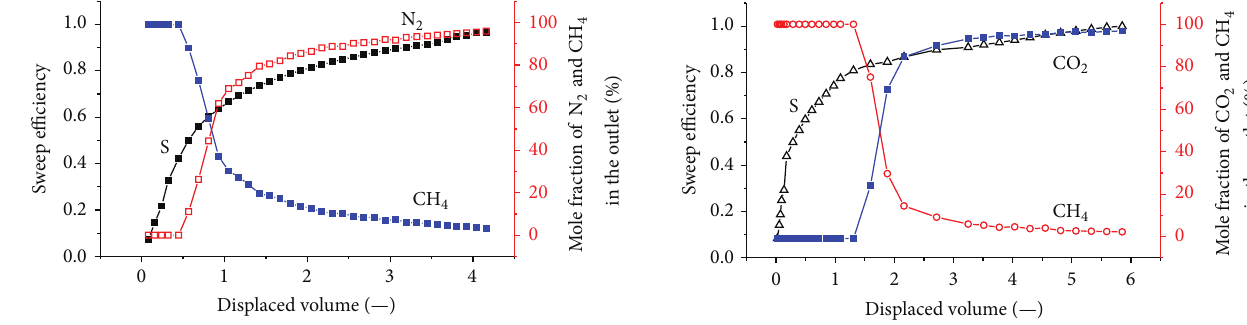
Figure 8: The sweep efficiency and concentrations of produced gas against displaced volume with a vertical stress of 14